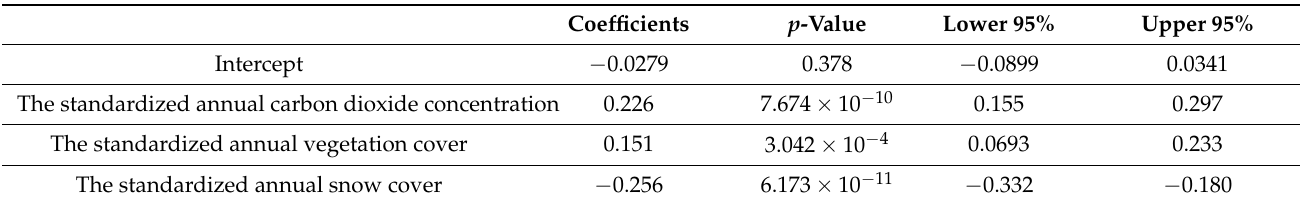
Table 7. T -test for each parameter